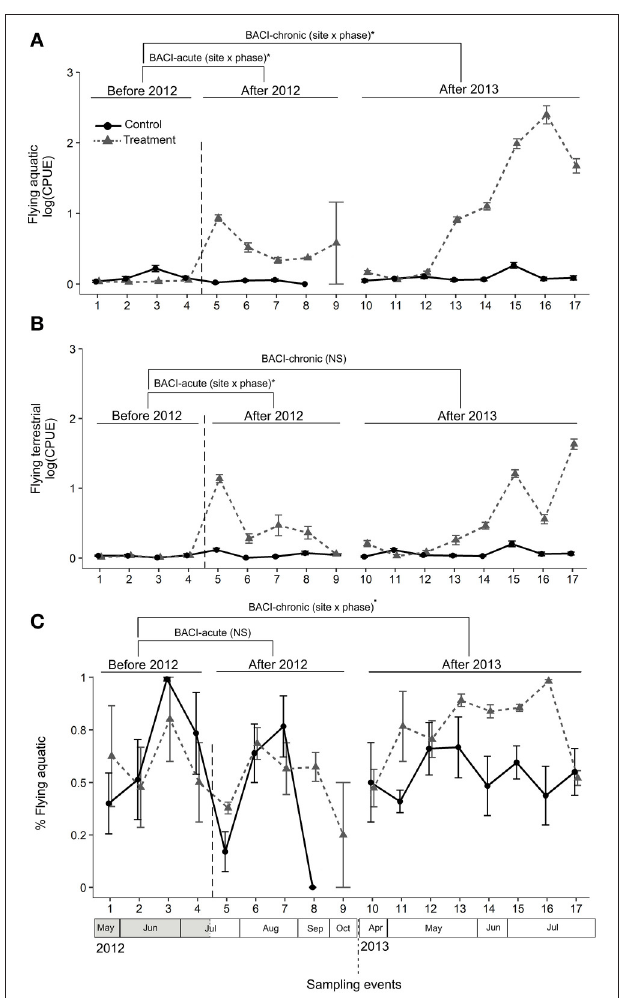
FIGURE 3 | Abundance (CPUE) of adult flying aquatic (A) and terrestrial (B) insects and proportion (%) of aquatic insect on the total (C) were compared across sampling events within and among years using a BACI design. Control and Treatment sites were first compared prior to and during experimental illumination in 2012 (BACI-acute; Before 2012 and After 2012). Sites were then compared prior to illumination in 2012 with the same period of the year in 2013, after experimental illumination (BACI-chronic; Before 2012, After 2013). Significant site × phase interactions (GLS) are shown as * p < 0.05; · 0.05 < p < 0.07; NS p > 0.07. Means across all traps with standard errors are shown for the two sites at each sampling event.